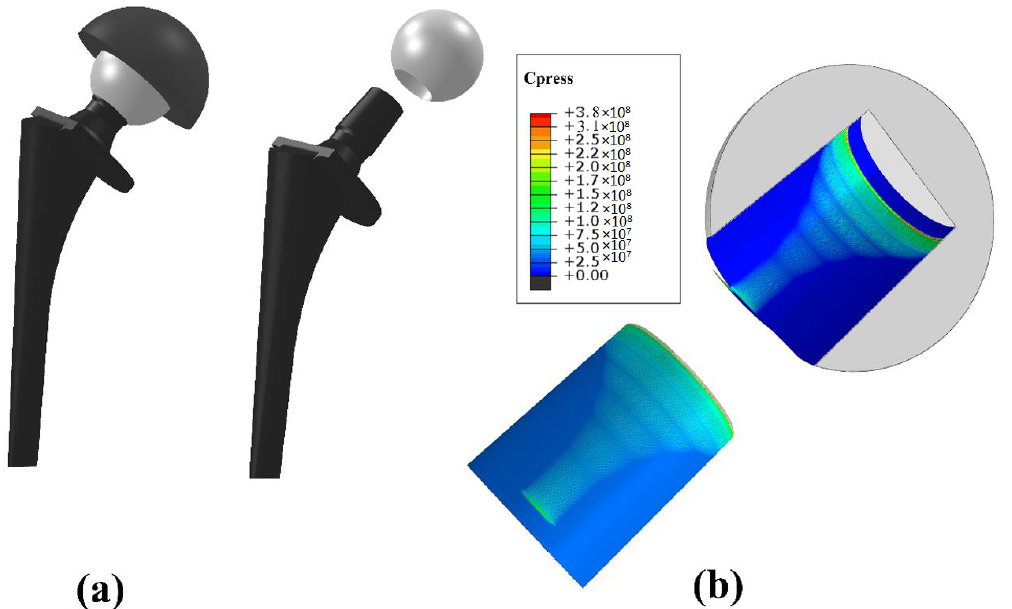
Figure 1. ( a ) A three-dimensional model of a hip joint implant and ( b ) distribution of contact pressure (in Pa) in both the head and neck under a normal walking gait loading, which indicates that the super-lateral region has the largest contacting area with both contact pressures and micro-motions.